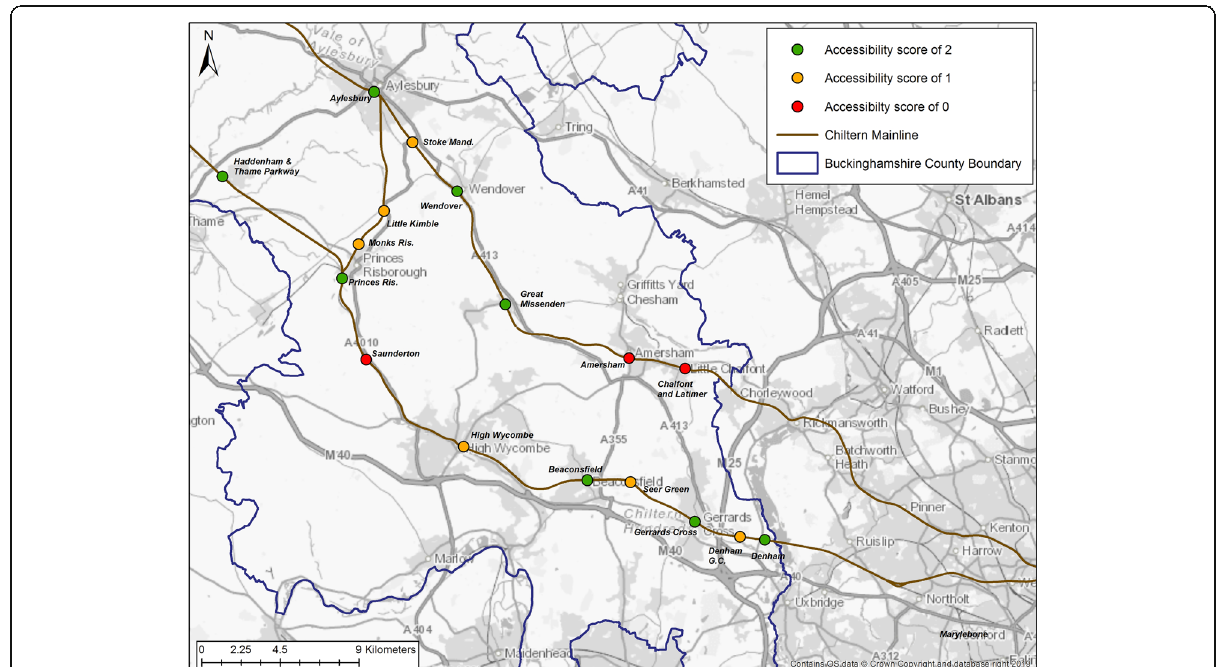
Fig. 4 Railway station accessibility grading (Source: Authors ’